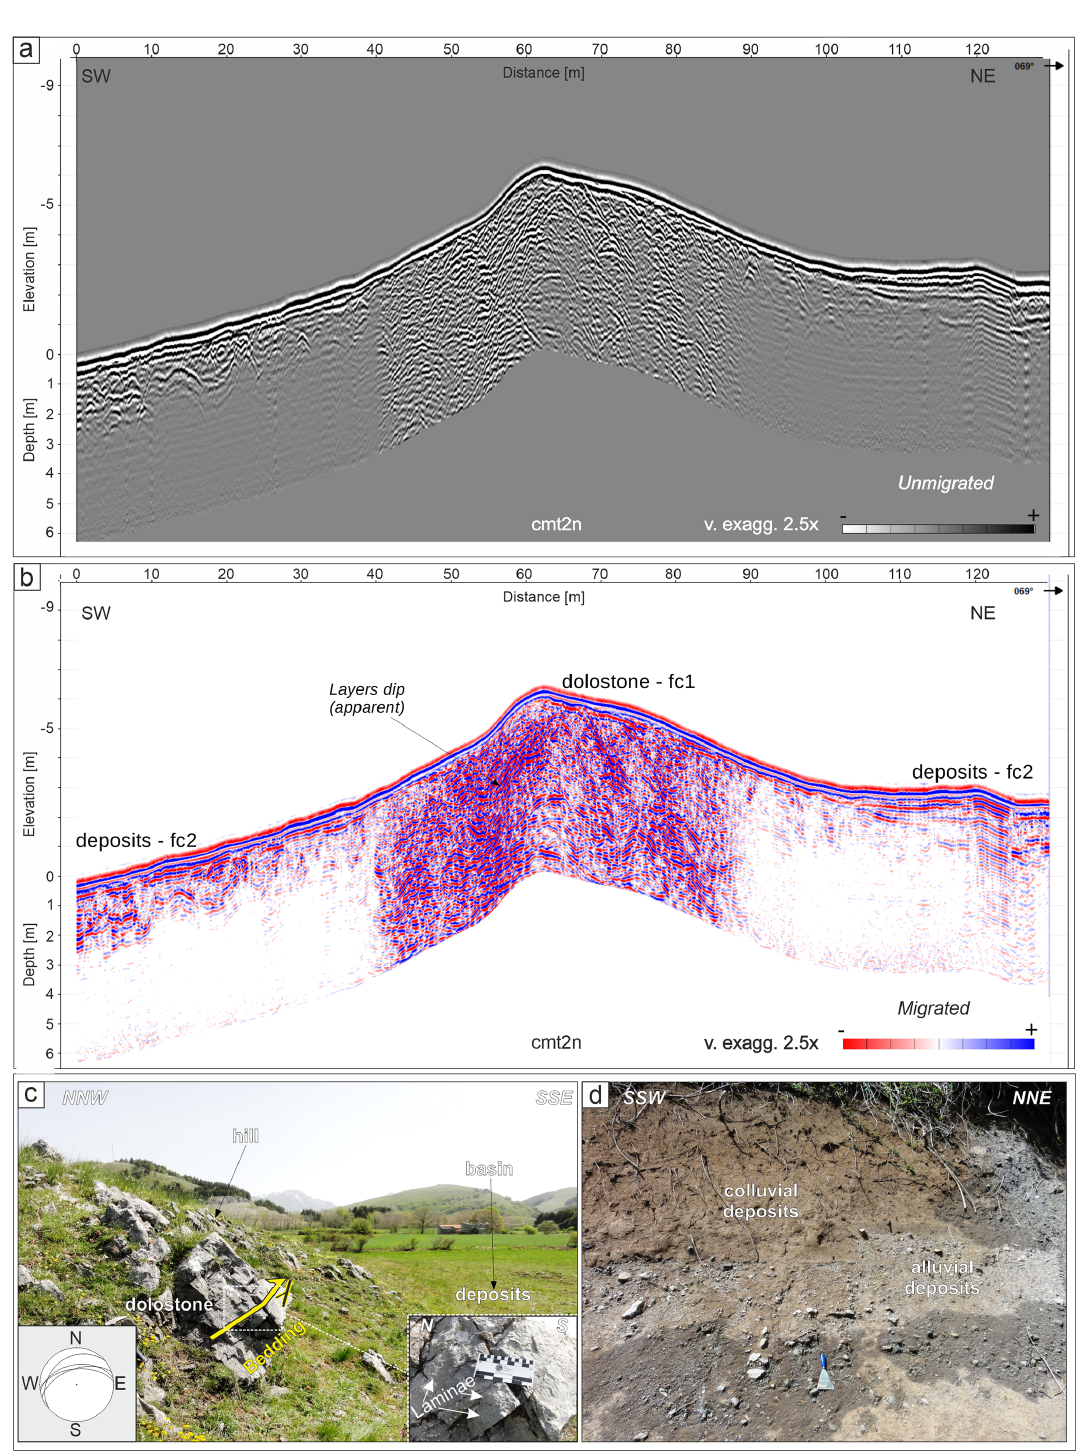
Figure 7. Correlation between GPR profiles and outcropping geology at the study site: (a) unmigrated 300MHz profile (cmt2n; see Fig. 2b for location) displaying numerous hyperbolic diffractions; (b) migrated profile displaying the apparent dip associated with fractured dolostone formation (facies fc1) and Quaternary deposits in the attenuated sectors (GPR facies fc2); (c) Quaternary deposits of the basin (on the background) surrounding the Triassic dolostone formation outcropping on the hill h1. The yellow arrows indicate the bedding, such as the stereonet (left-side inset); the right-side inset shows details of the laminae visible on the site and nearby; (d) an example of Quaternary colluvial and alluvial deposits outcropping nearby the survey site. Vertical exaggeration is 2.5.